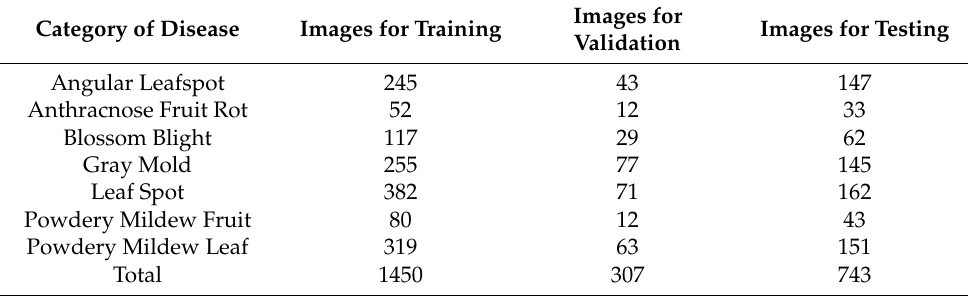
Figure 2. The seven types of strawberry diseases that our model is trained to detect. Table 4. A summary of our